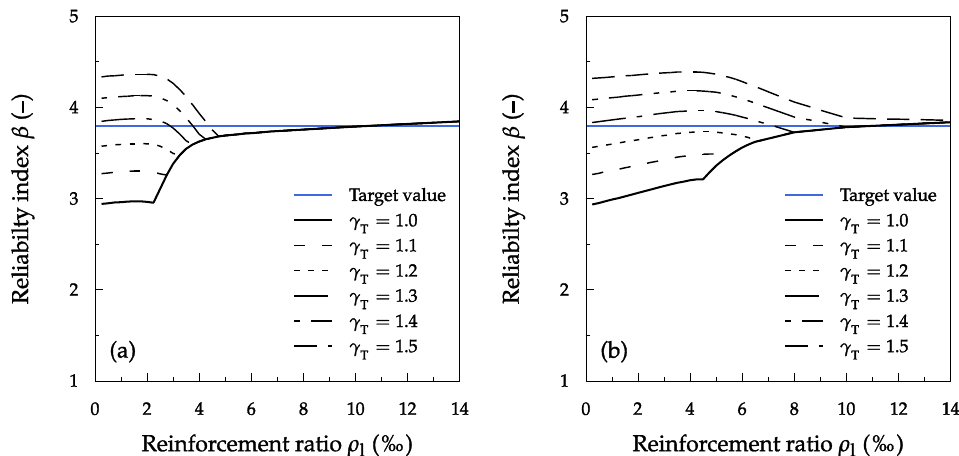
Figure 9. Reliability indices calculated according to FORM considering an effective depth of d = 60 mm: ( a ) linear σ–ε diagram; ( b ) rectangular σ–ε diagram.